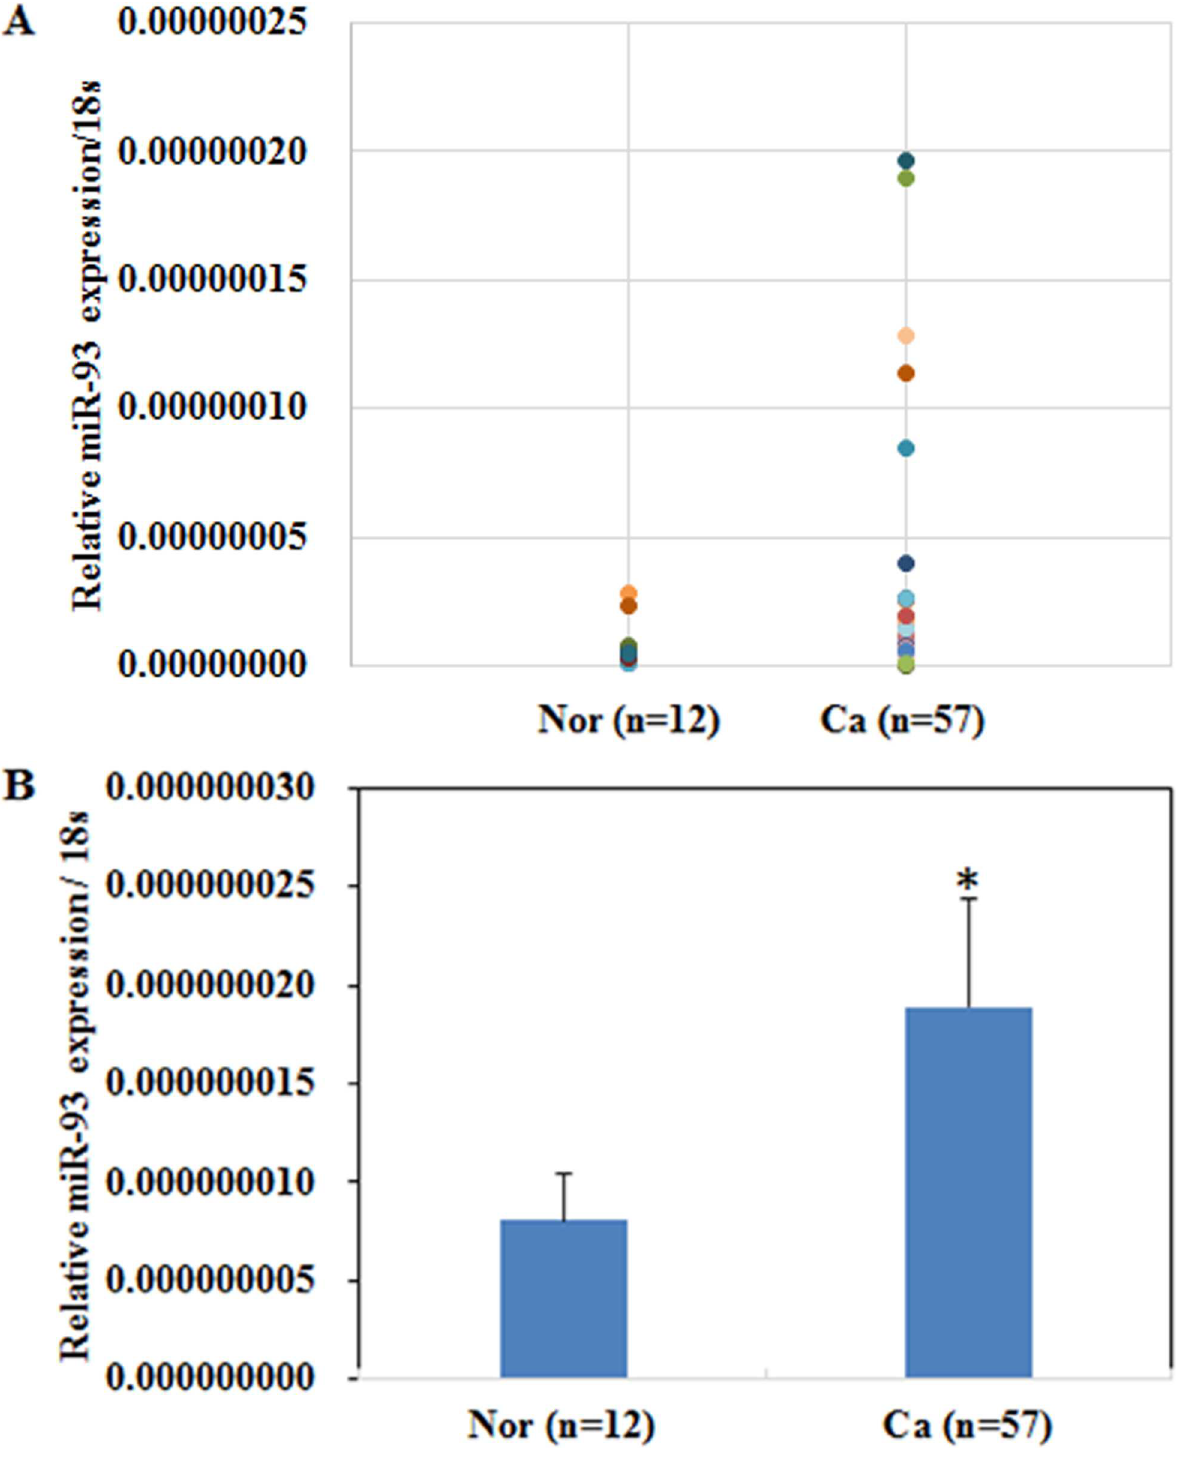
Fig 1. MiR-93 expressionin endometrial carcinoma tissues and normal endometrial specimens. Expression levels of miR-93 in both endometrial carcinomasamples and normalsamples were analyzedby RT-PCR (A) . MiR-93 was highly expressedin EC tissue than in normal samples (B) . * P <